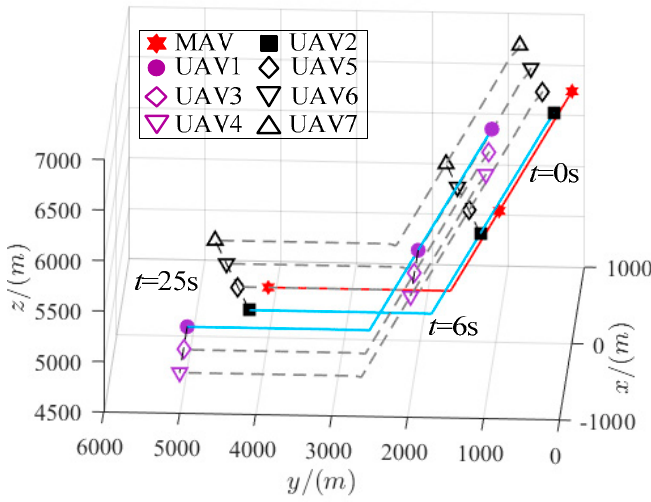
Figure 5. The 3D-flight diagram of MAV/UAVs group formation.